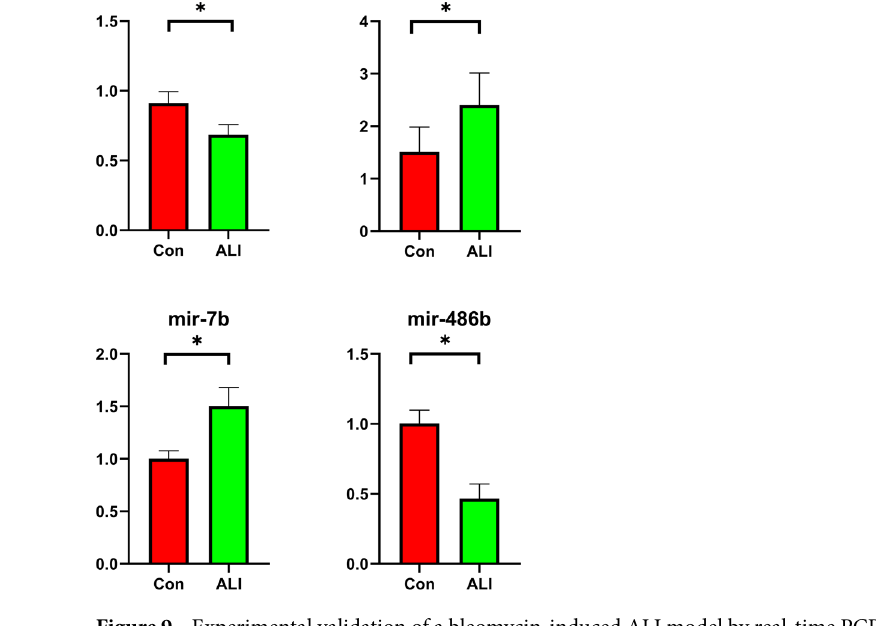
Figure 9. Experimental validation of a bleomycin-induced ALI model by real-time PCR. The expression of miR-7b was significantly upregulated and that of the Gria1 gene was downregulated in the ALI groups.